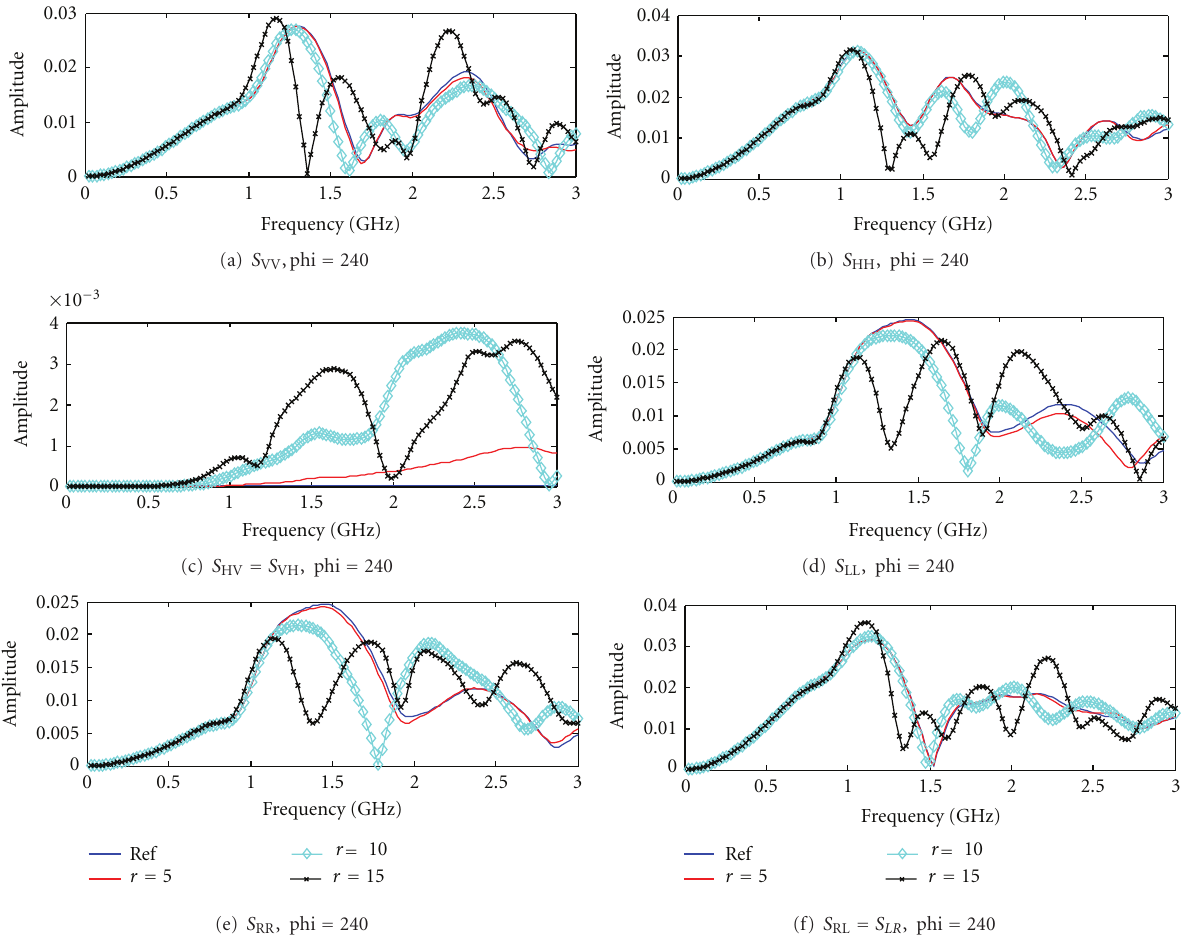
Figure 4: Amplitude response from breast volumes in frequency domain at θ = 105 ◦ , ϕ t = ϕ r = 240 ◦ . (a) S VV , (b) S HH , (c) S HV = S VH , (d) S S S = S LL , (e) RR , and (f) RL LR